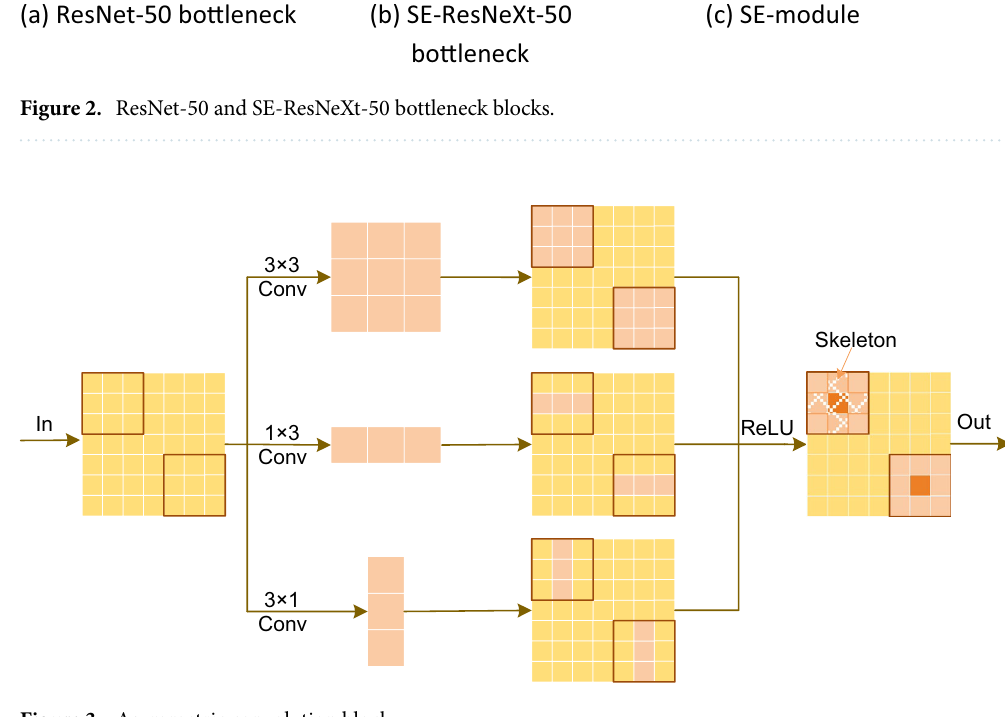
Figure 3. Asymmetric convolution